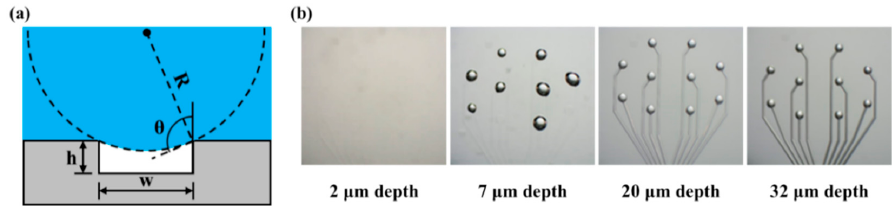
Figure 7. The experiment of air pocket entrapment. ( a ) Schematic of air pocket entrapment and variable descriptions (R: water radius, θ : contact angle, w : trench width, h : trench depth). ( b ) Experimental results of air pocket entrapment according to depth of concave structure. Some images were adapted and modified from a doctoral dissertation [25,26].